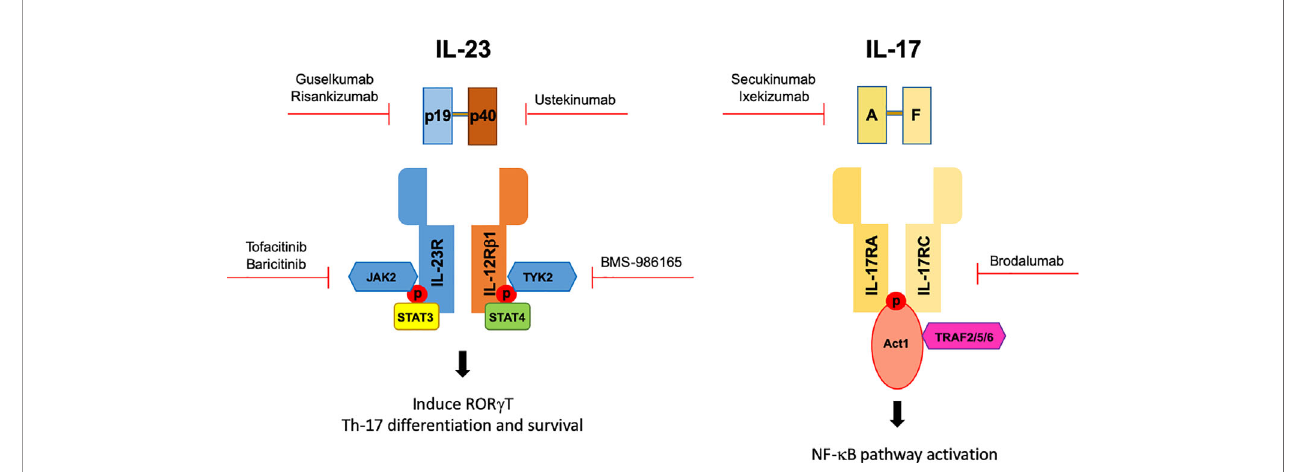
FIGURE 1 | Genetics studies allowed the identi fi cation of the IL-23/IL-17 axis having a crucial functional role in PsA pathogenesis. Genetics lead to the development of biological drugs targeting the IL-23/IL-17 axis in PsA. Red arrow indicates the target of different